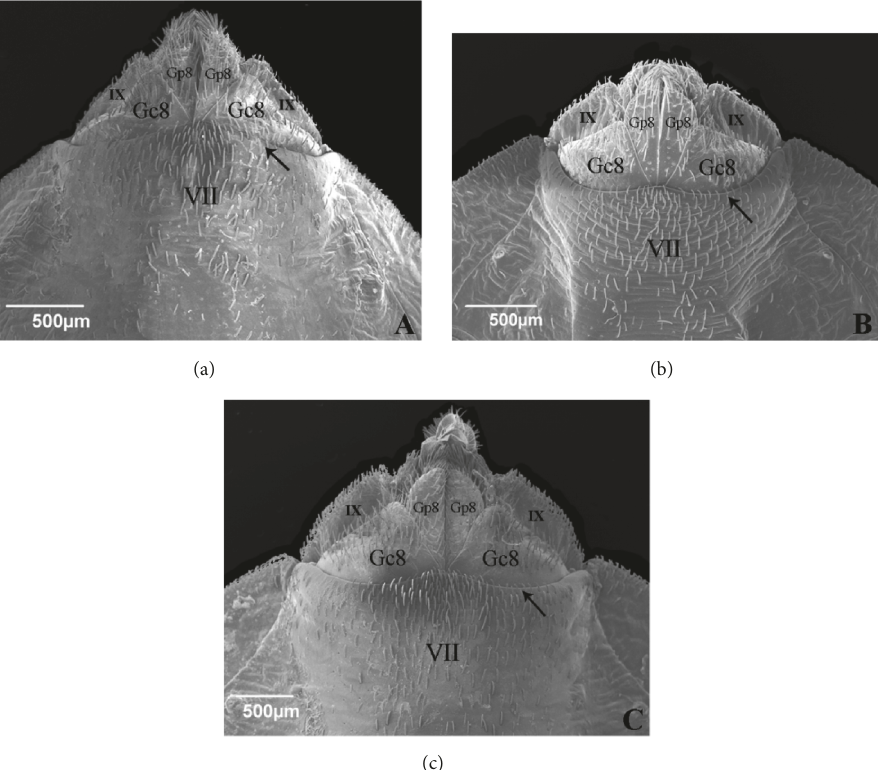
Figure 5: Ventral view of external female genitalia. (a) Triatoma carcavalloi. (b) Triatoma circummaculata. (c) Triatoma rubrovaria. Gc8: gonocoxite 8. Gp8: gonapophyses 8. VII: sternite 7: IX: sternite 9. Line separating the VII sternite and the pair of VIII gonocoxites